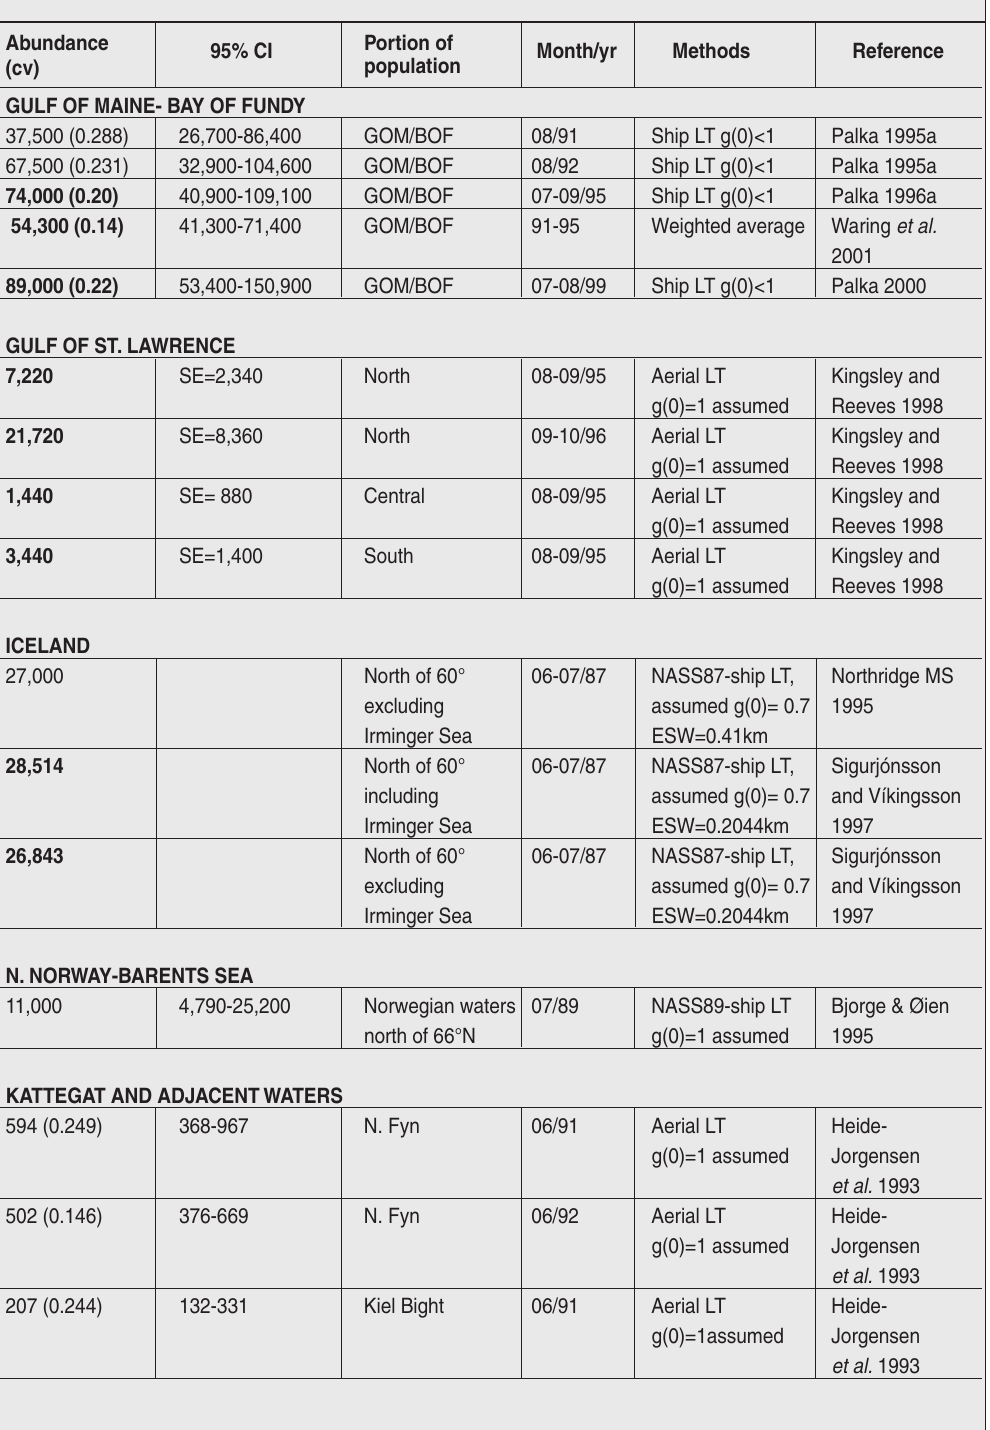
Table 1 . Abundance estimates of harbour porpoises in the North Atlantic. Estimates obtained after the review by IWC in 1995 (Donovan and Bjørge 1995) are shown in bold. LT= line transect; g(0)=proportion of animals seen on the trackline; ESW=estimated strip